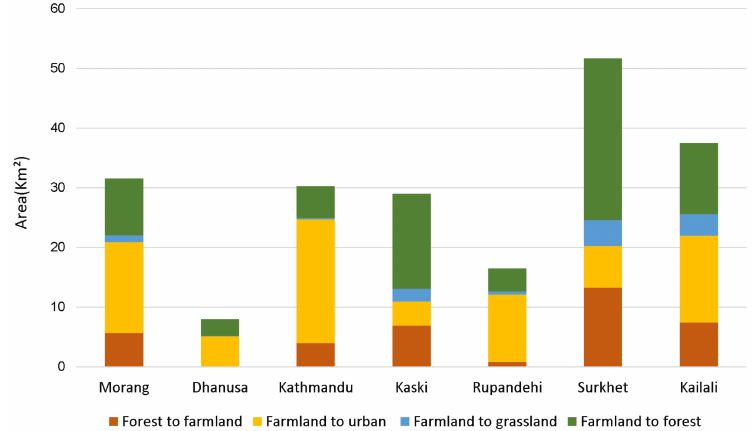
Figure 6. The composition of four kinds of land cover changes in seven interest districts from 2016 to